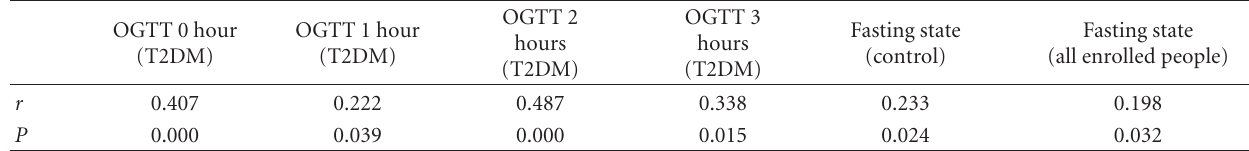
Table 3: Correlation analysis between serum resistin and salivary resistin levels at each time point of OGTT in T2DM group or fasting state in control group and merged group.